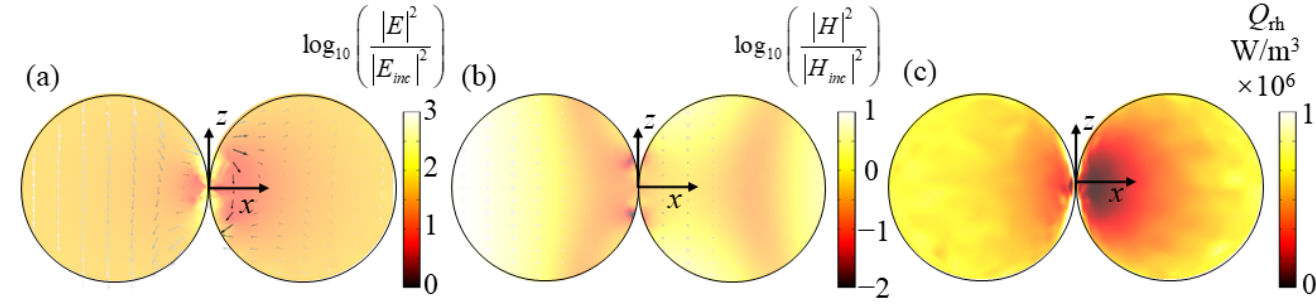
Figure 3. ( a – c ) show the electric/magnetic field and resistive heat distributions of dimer at λ = 410 nm for x -incidence with z -polarization, respectively.